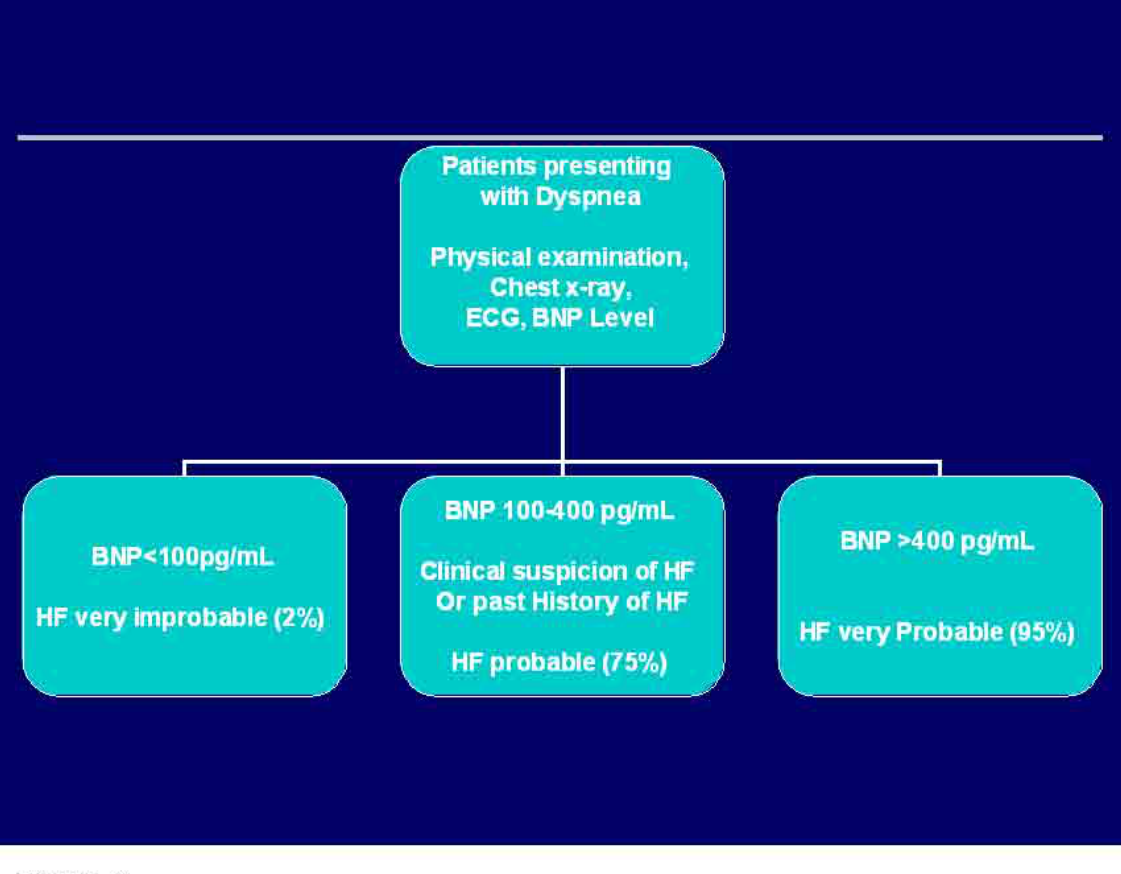
Algorithm of BNP use at presentation for acute